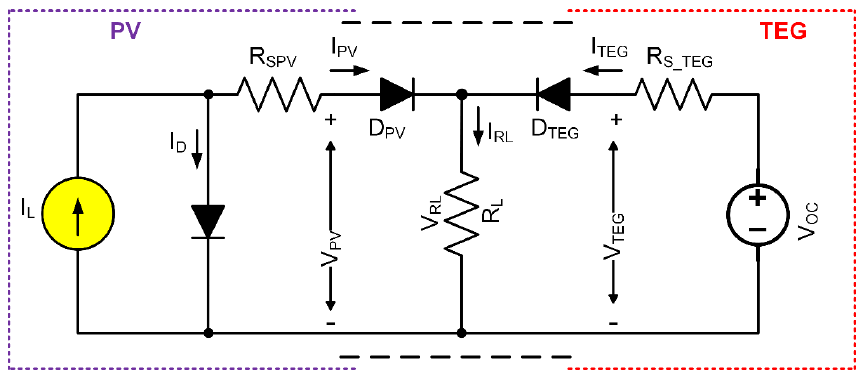
Figure 3. The equivalent electrical circuit of the proposed